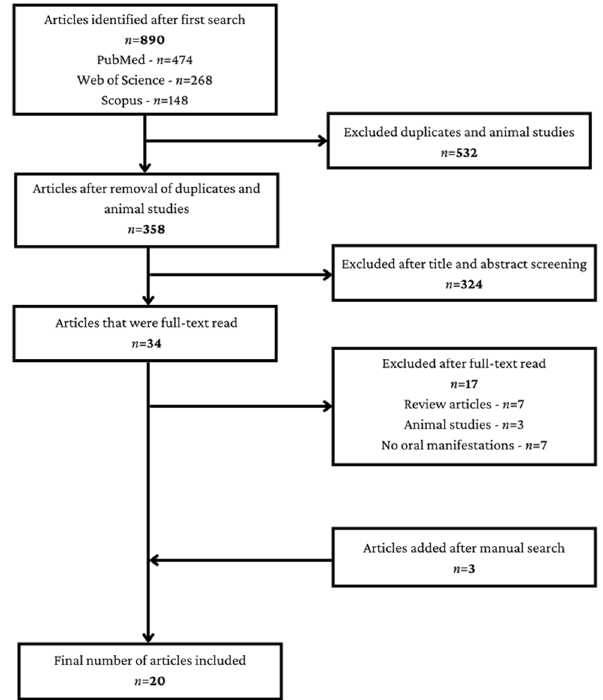
Figure 1. Study selection process.